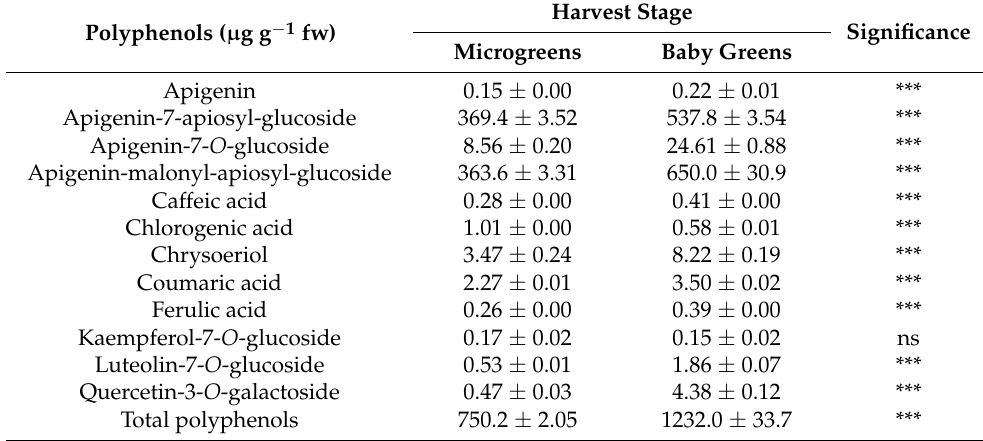
Table 3. Single and total polyphenols of Petroselinum crispum in virtue of harvest stage. Harvest Stage Significance Polyphenols ( µ g g − 1 fw) Microgreens Baby Greens Apigenin 0.15 ± 0.00 0.22 ± 0.01 *** Apigenin-7-apiosyl-glucoside 369.4 ± 3.52 537.8 ± 3.54 *** Apigenin-7- O -glucoside 8.56 ± 0.20 24.61 ± 0.88 *** Apigenin-malonyl-apiosyl-glucoside 363.6 ± 3.31 650.0 ± 30.9 *** Caffeic acid 0.28 ± 0.00 0.41 ± 0.00 *** Chlorogenic acid 1.01 ± 0.00 0.58 ± 0.01 *** Chrysoeriol 3.47 ± 0.24 *** Coumaric acid 2.27 ± 0.01 *** Ferulic acid 0.26 ± 0.00 0.39 ± 0.00 *** Kaempferol-7- O -glucoside 0.17 ± 0.02 0.15 ± 0.02 ns Luteolin-7- O -glucoside 0.53 ± 0.01 1.86 ± 0.07 *** Quercetin-3- O -galactoside 0.47 ± 0.03 4.38 ± 0.12 *** Total polyphenols 750.2 ± 2.05 1232.0 ± 33.7